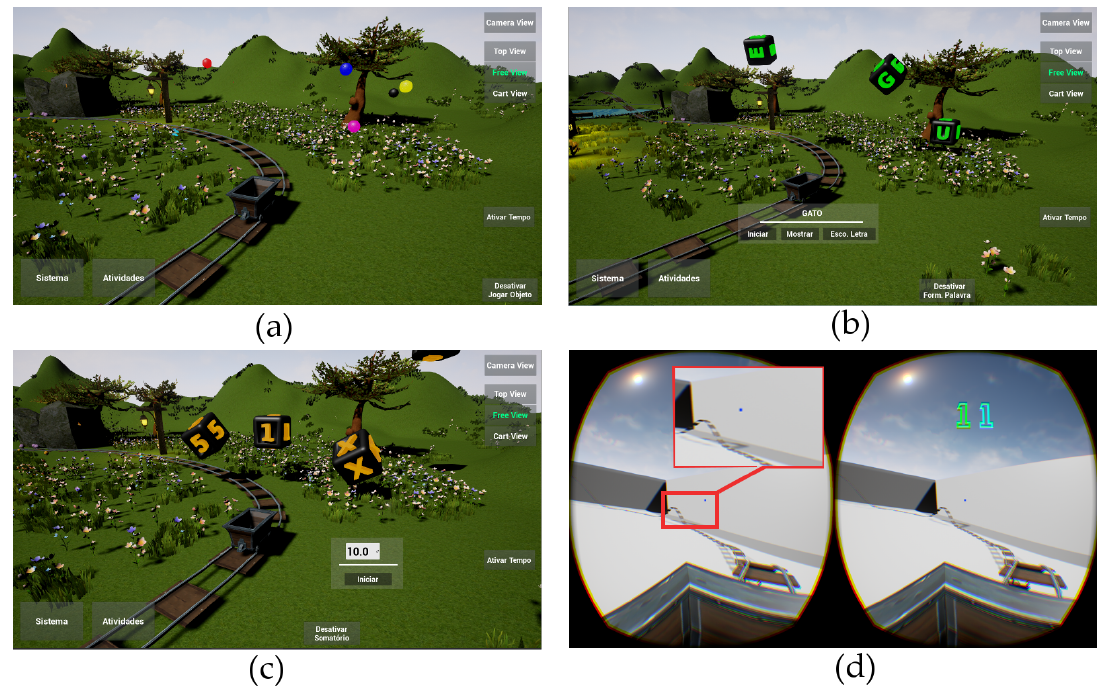
Figure 5. Images ( a – c ) depict the screenshots for the 3 games available in Imaginator as seen from the OT’s interface. Image ( a ): Playing Ball—The goal in the example is to look at the red ball. Image ( b ) Forming Word—The goal in the example is to look at the each letter which composes the word “Gato” (cat). Image ( c ) Summation—The goal in the example is to look at the numbers until they add up to 10. Image ( d ) shows the blue squared dot present in the patient’s interface to indicate the focus of the gaze being considered.